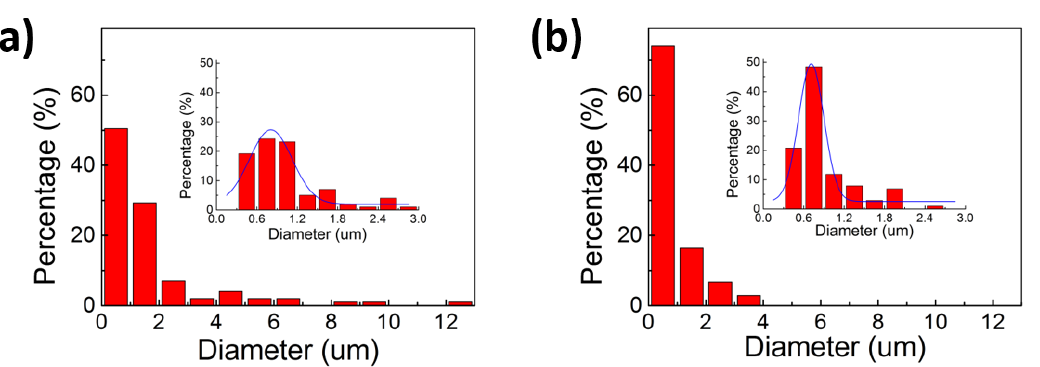
Figure 4. Fiber diameter distributions of PP nonwoven fabric prepared by conventional melt blowing ( a ) and electrostatic-assisted melt blown ( b ). Insets are the diameter distributions of each group in the 0–3 μm range.